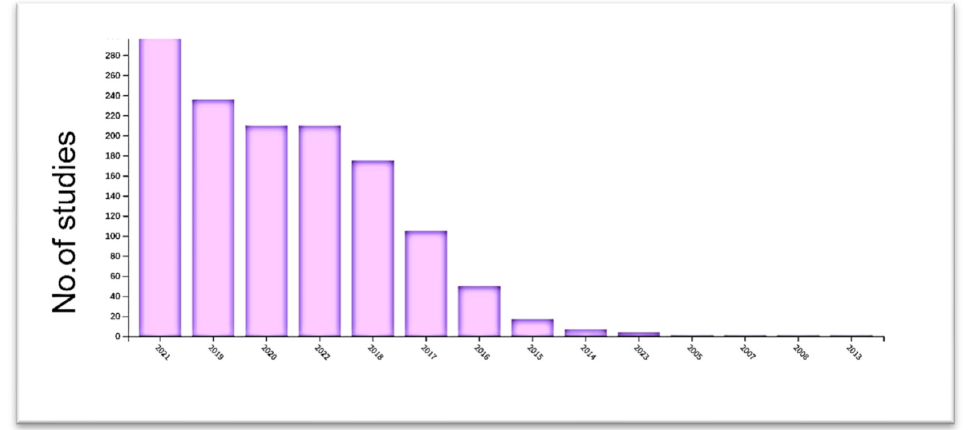
Figure 4. The distribution of CNN techniques in WOS on an annual basis. Since 2015, the number of studies on CNN applications in WOS has increased